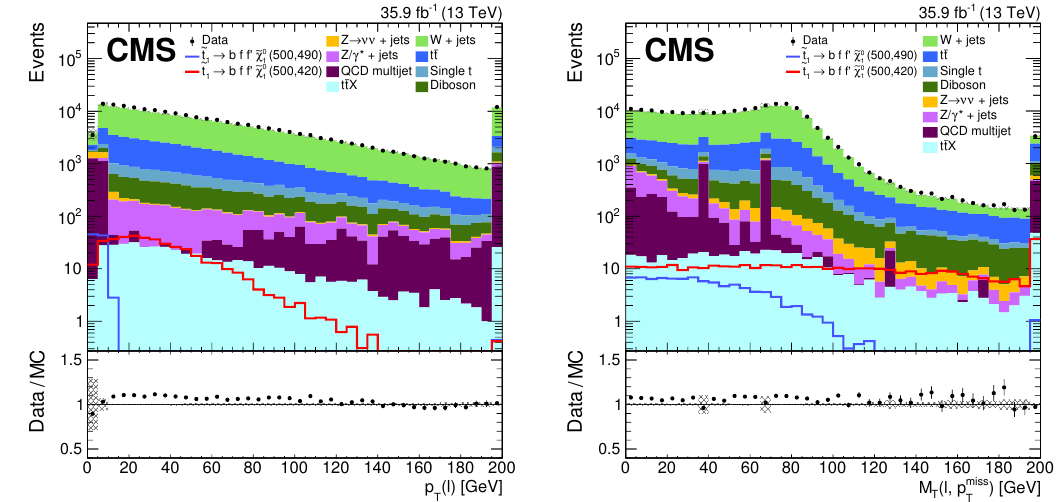
Figure 2 . Distributions of lepton p T (left) and M T (right) at the preselection level in data and simulation. The lower panels show the ratio of data to the sum of the SM backgrounds where the dark shaded bands indicate the statistical uncertainties of the simulation. The distributions of two signal points of the four-body decay are also represented, while not being added to the background: ( m ( t 1 ) ; m ( (cid:31) 0 )) = (500,490) and (500,420) GeV. The background distributions are obtained directly 1 from simulation, and are normalized to an integrated luminosity of 35.9 fb (cid:0) 1 . The last bin in each e plot includes events beyond 200 e